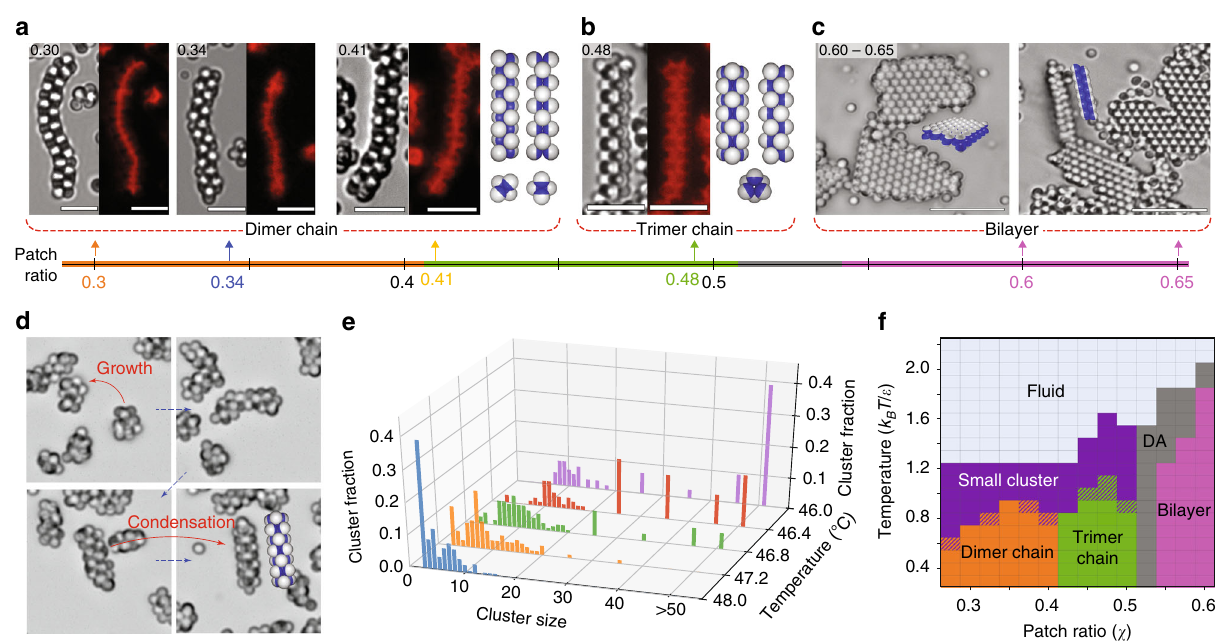
Fig. 4 DNA-mediated self-assembly of Janus particles with patch ratios from 0.3 to 0.65. a Bright- fi eld and fl uorescent images for self-assembled structures of DNA-coated Janus particles with patch ratios from 0.3 to 0.65. Particles with patch ratios from 0.3 to 0.41 self-assemble into fl exible dimer chains. The colors on the patch-ratio axis follow those of the phase diagram shown in frame ( f ). b Particles with a patch ratio of 0.48 self-assemble into stiff densely-packed trimer chains. c Particles with patch ratios of 0.6 and 0.65 self-assemble into bilayer structures. The right-most image shows a cross- section of a bilayer structure. d Still frames from Supplementary Movie 5 showing the assembly of a trimer chain. Disordered chains form and grow by combining with clusters, and subsequently condense into trimer chains. e Fraction of clusters that are found in clusters of different size. For cluster sizes greater than 20, the histogram bars integrate over ten or more bins: 21 – 30, 31 – 40, 41 – 50, >50. f Phase diagram as a function of patch ratio and temperature, obtained by computer simulation (DA: disordered